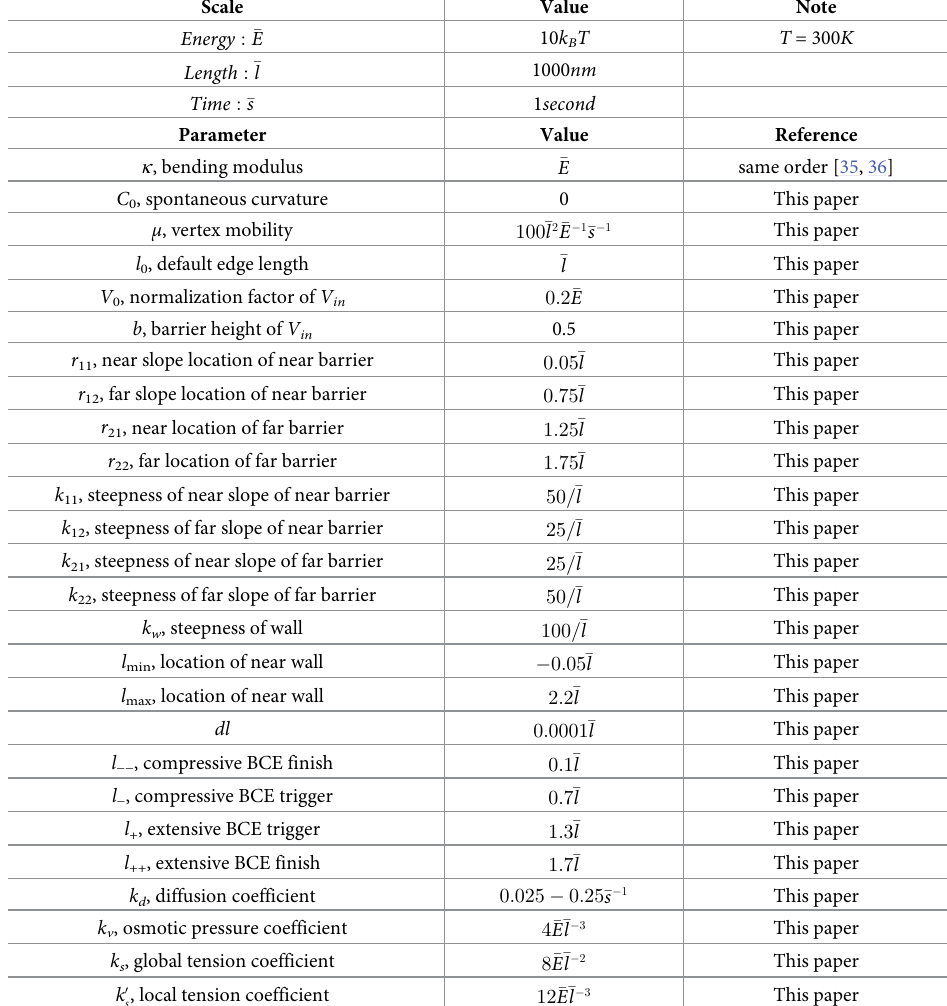
Table 1. Parameter values. Scale